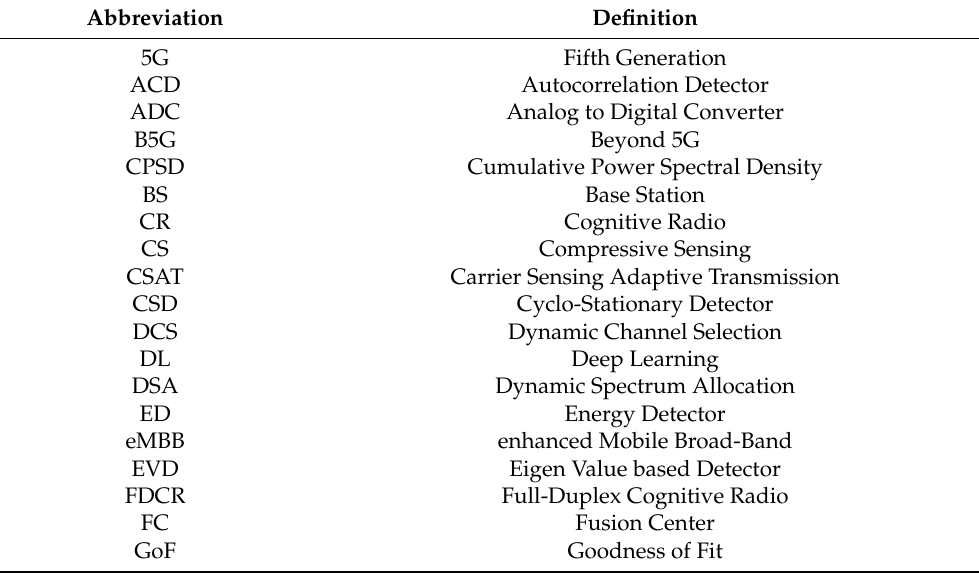
Table 1. List of abbreviations used in the